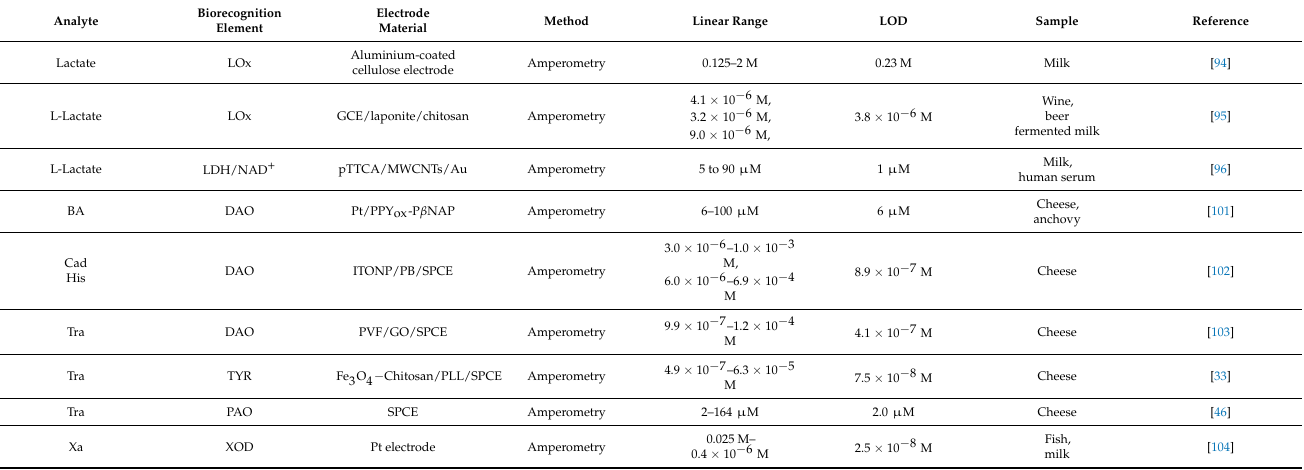
Table 4. Enzyme-based amperometric biosensors for biogenic amine determination in dairy